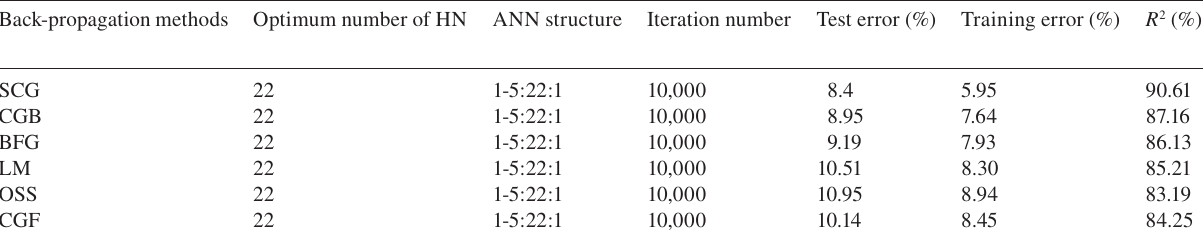
Table 3 Values of load failure point of the structures (Vfailure). Back-propagation methods Optimum number of